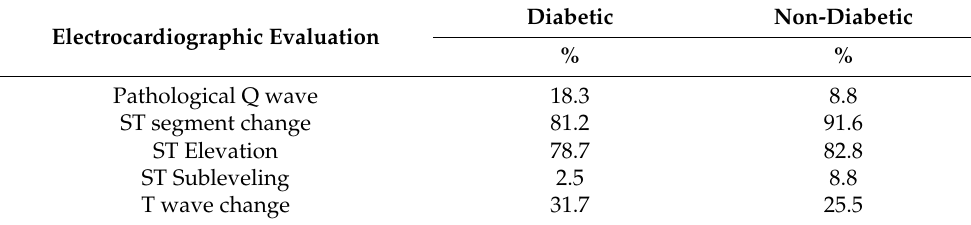
Table 2. Electrocardiographic evaluation case distribution at hospitalization.